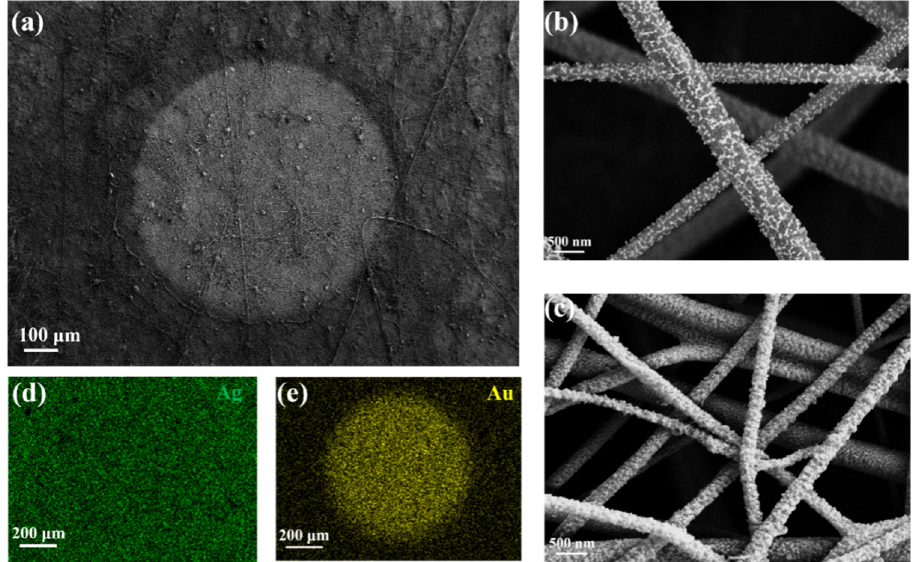
Figure 3. ( a ) SEM image of HWS. ( b ) The enlarged SEM images of hydrophobic Ag-PAN and ( c ) hydrophilic Au/Ag alloy nanocomposites, respectively. ( d ) The corresponding spatial element distribution of hydrophobic area and ( e ) hydrophilic SERS active area.